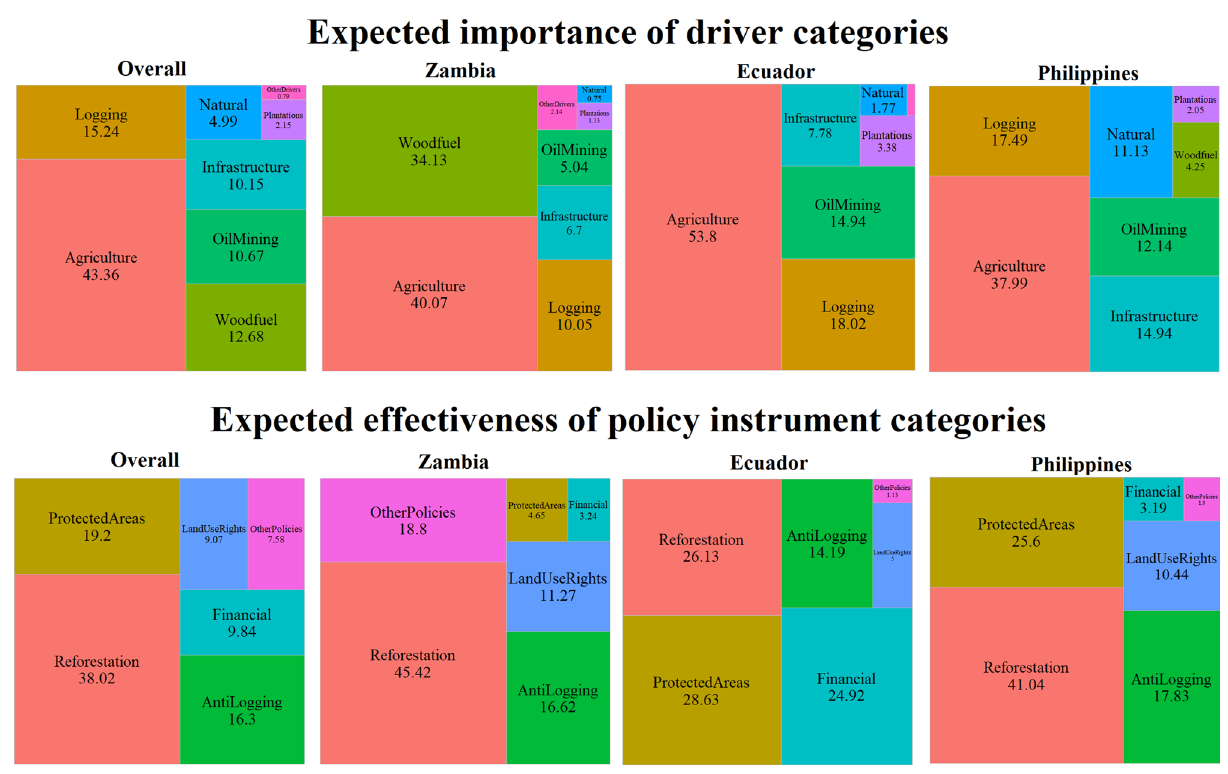
Figure 2. Tree maps representing the overall expected importance of the driver categories and the expected effectiveness of the policy instrument categories in the total sample and in the country subsamples. Natural refers to NaturalDisasters , Financial refers to FinancialTools .